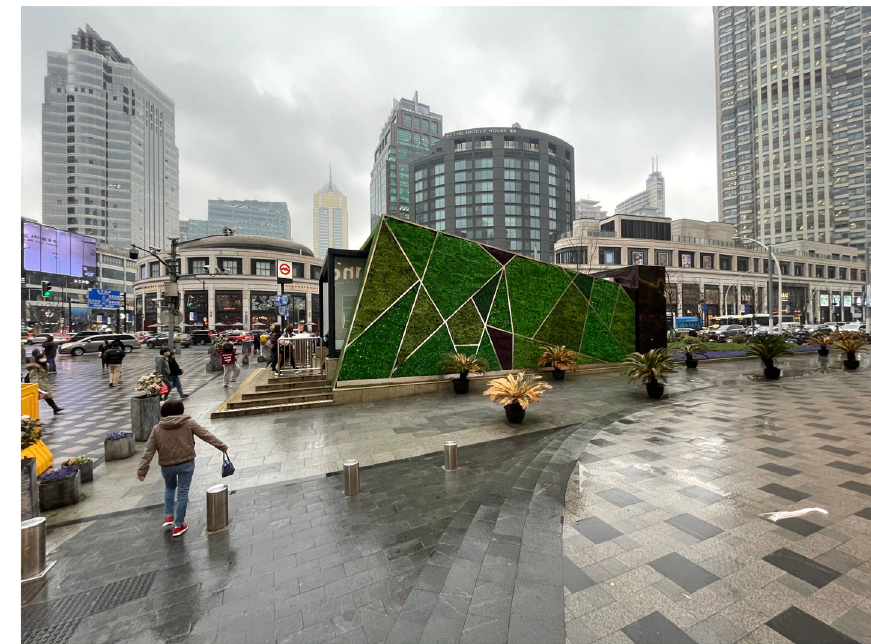
Fig. 5 Entrance to West Nanjing Road Metro Station (metro line 11). (Source: the